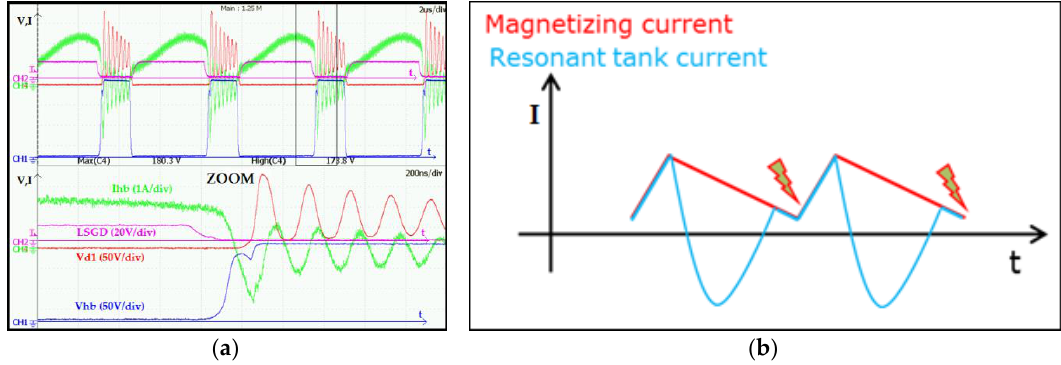
Figure 4. Undesired conditions for ZVS operation: ( a ) ZVS is achieved with Lr , large oscillations are observed in D 1 voltage due to secondary leakage inductance ( b ) tank current polarity does not allow ZVS operation and leads to body diode cross-conduction when Q 1 is switched